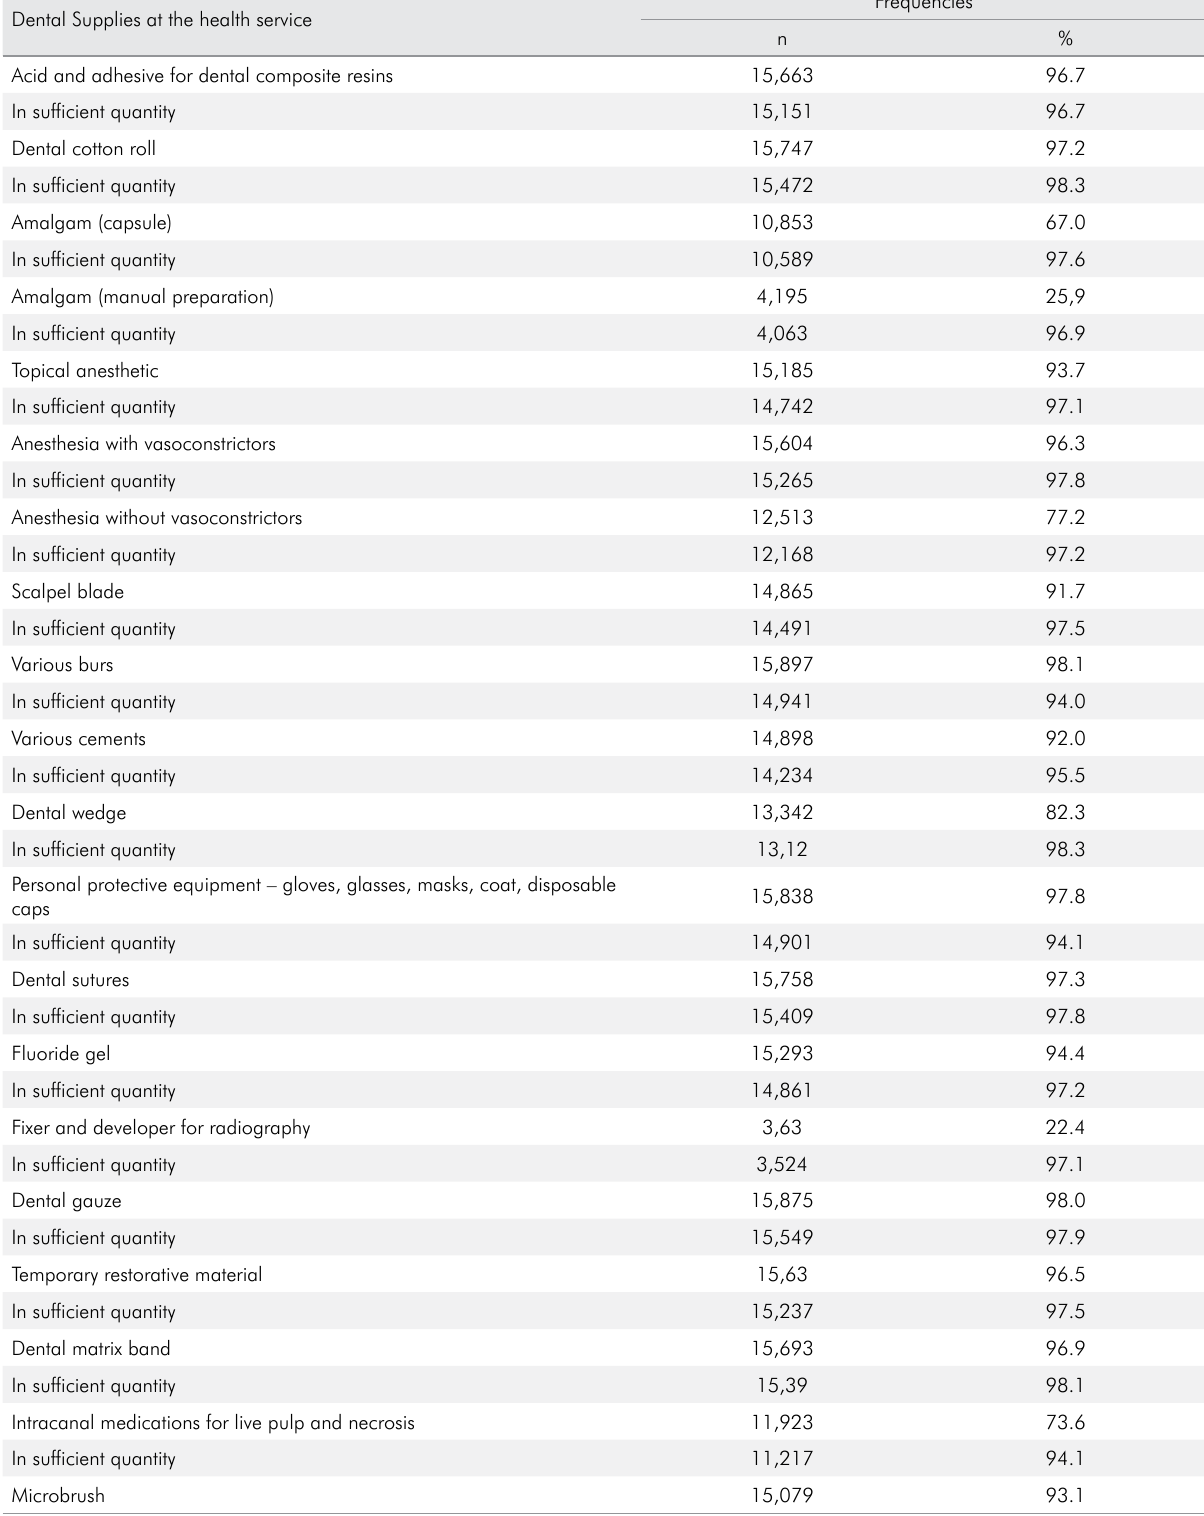
Table 3. Descriptive analysis of dental supplies present in the oral health services evaluated in this study. PMAQ-AB. Brazil, 2013-2014 (n =